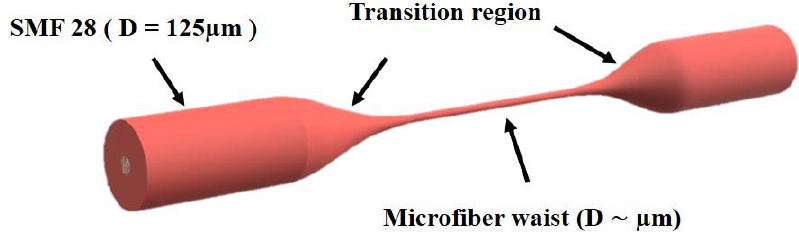
Figure 1. Schematic of an optical MF. A uniform waist region (center) is connected to single mode optical fiber pigtails (SMF 28) by conical transition regions.